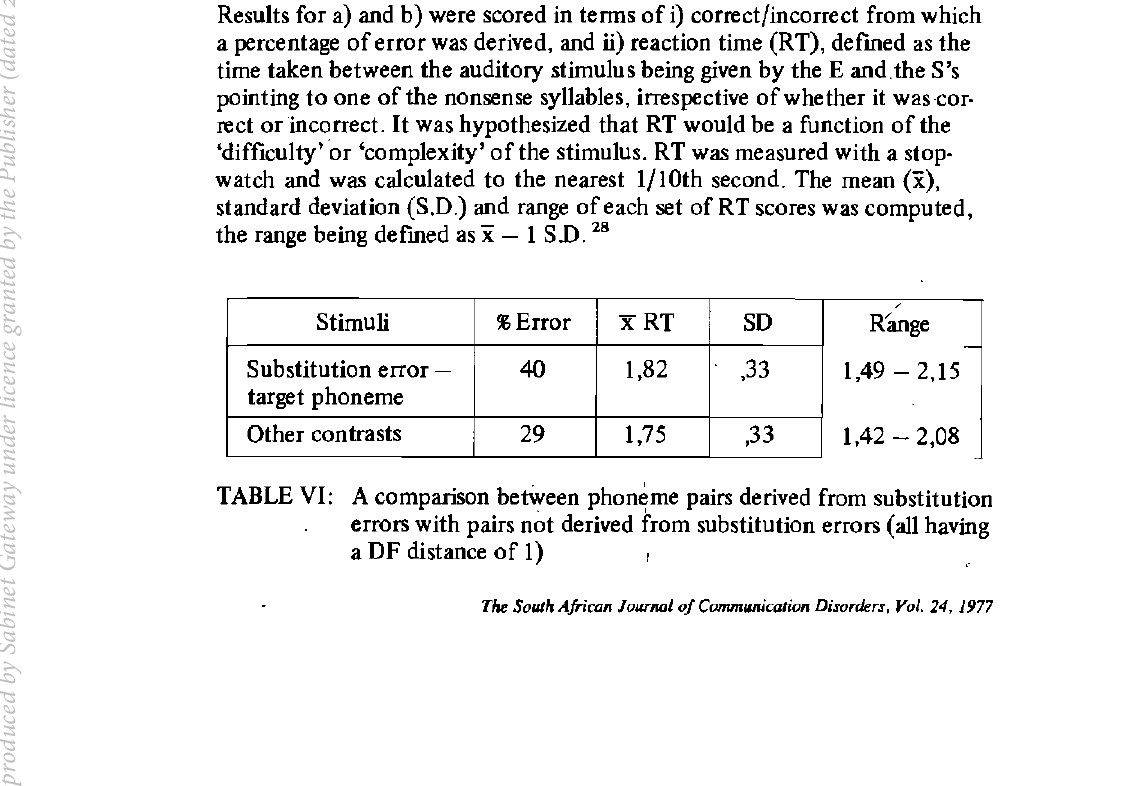
TABLE VI: A comparison between phoneme pairs derived from substitution errors with pairs not derived from substitution errors (all having a DF distance of